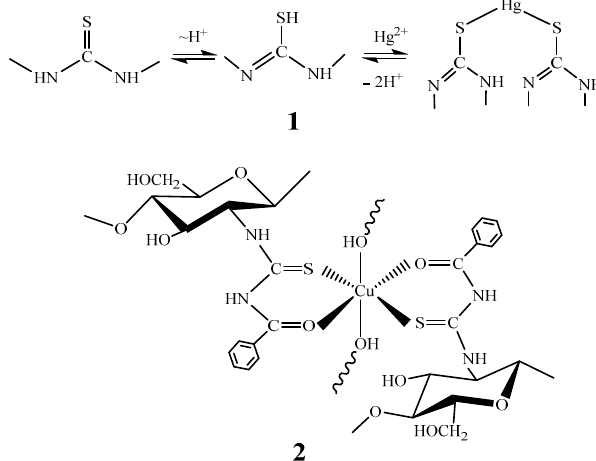
Figure 12. Suggested structures of complexes with thiocarbamoyl derivatives of chitosan, 1 —adapted from [126]; with chitosan benzoyl thiourea derivative, 2 —adapted from [94].